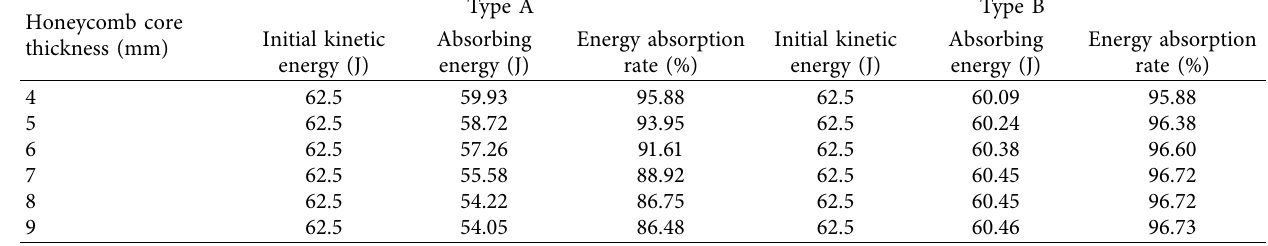
Table 7: Energy absorption capacity with different thicknesses of honeycomb cores.